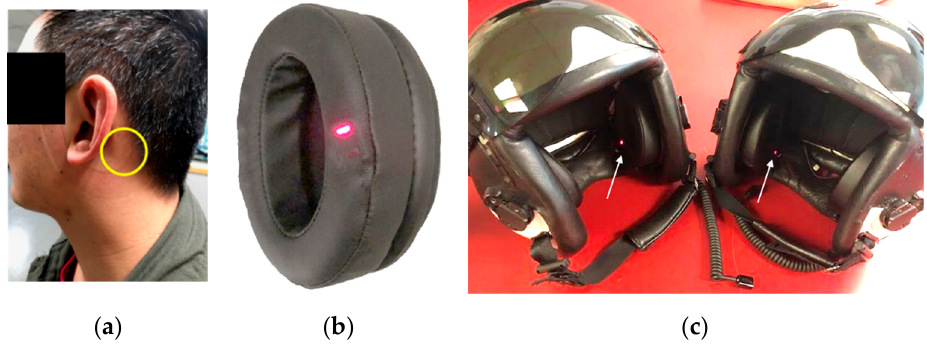
Figure 1. ( a ) Photograph of a test subject after removing helmet instrumented with SPYDR earcups. The yellow circle indicates optimal anatomical placement of the SPYDR sensor when worn. ( b ) Photograph of the SPYDR ear-cup. The multi-wavelength plethysmography sensor is seen as the red light embedded in the ear-seal. ( c ) Photograph of Navy flight helmets HGU-68, configured for tests with SPYDR installed. The white arrow indicates the red light of the sensor.